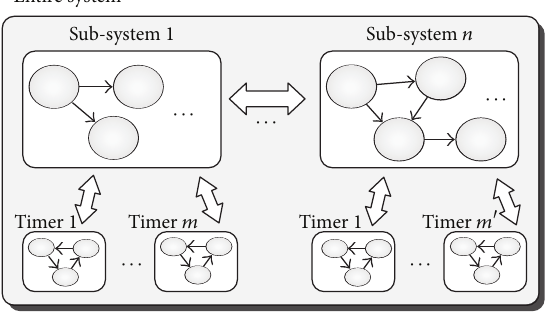
Figure 4: A model composition for the entire ENS.